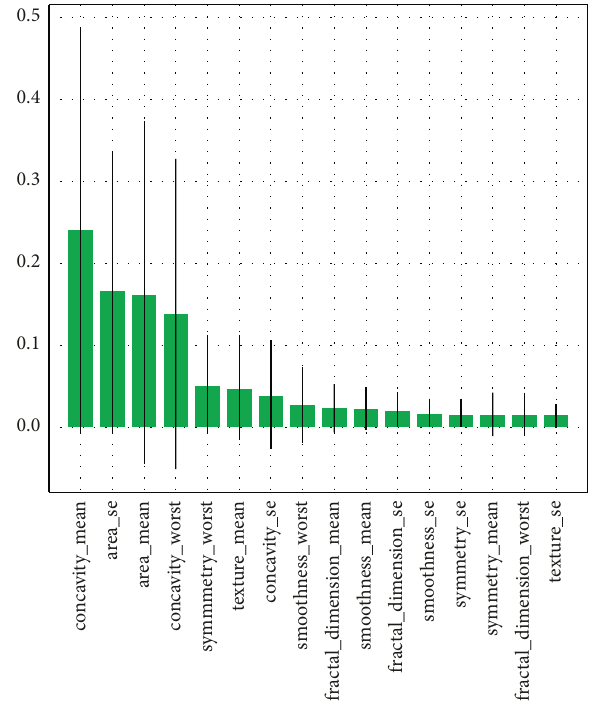
Figure 4: Feature